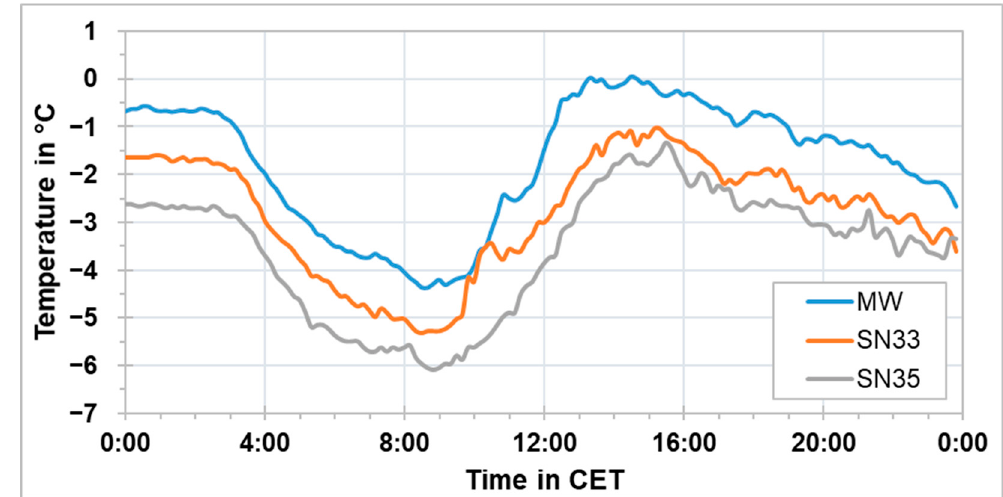
Figure 8. Air temperature at three stationary locations along the route of the rack railway on 21 February 2019 for 24 h.